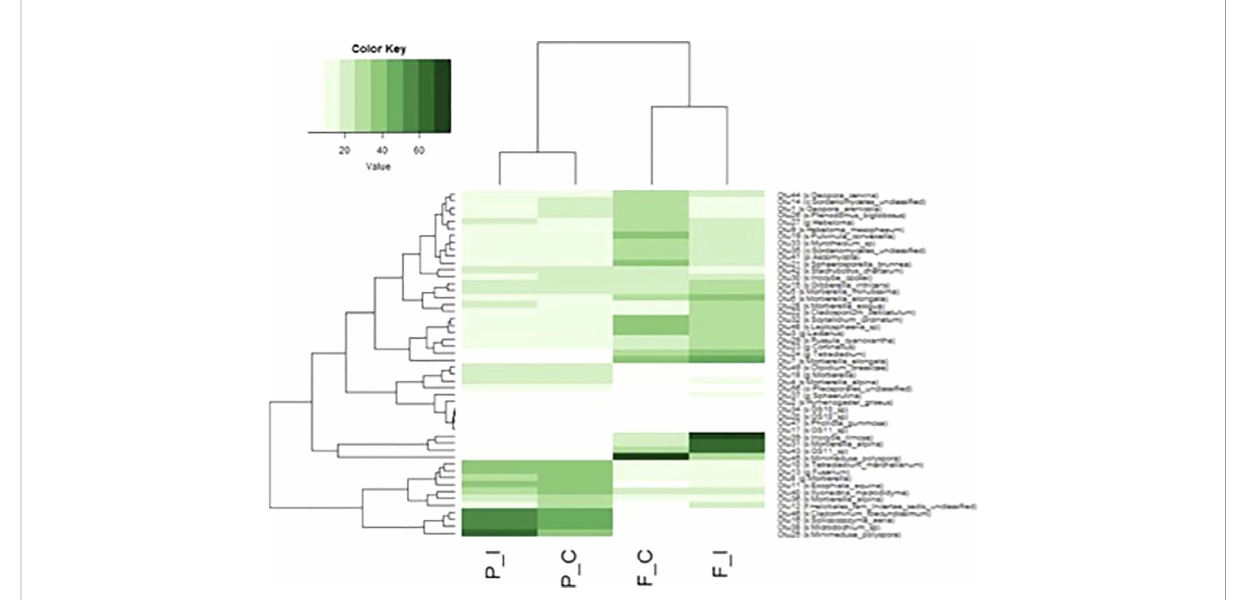
FIGURE 5 Comparison of the abundance of fungal OTUs among the 50 most abundant OTUs in at least one of the two sites (Fresnes-sur-Escaut, F; Pierrelaye, P) and two treatments (control, C; inoculated, I). The dendrogram represents linkage clustering using Euclidean distance measures. OTU delineation was based as the cutoff of 97% sequence similarity. Assignements between brackets indicate the lower taxonomic level associated with the OTU using the Greengenes database, k, kingdom; p, phylum; o, order; c, class; f, family; s, genus and